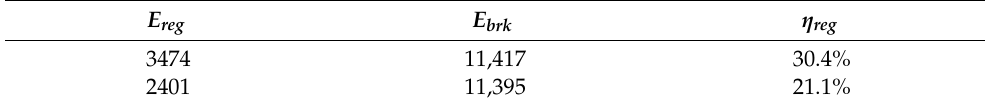
Figure 13. Vehicle deceleration-time.